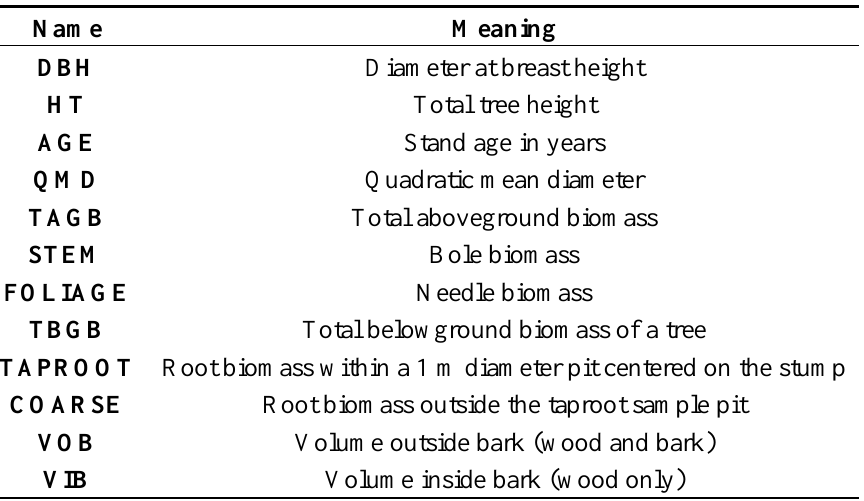
Table 1. List of acronyms.